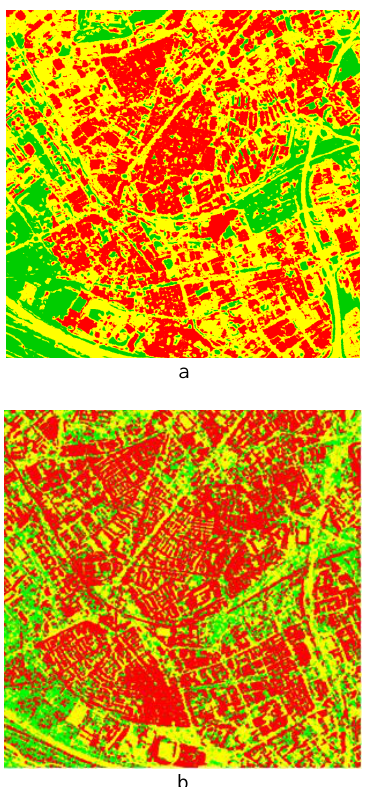
Figure 3. SVM classification result on a) SPOT, b)